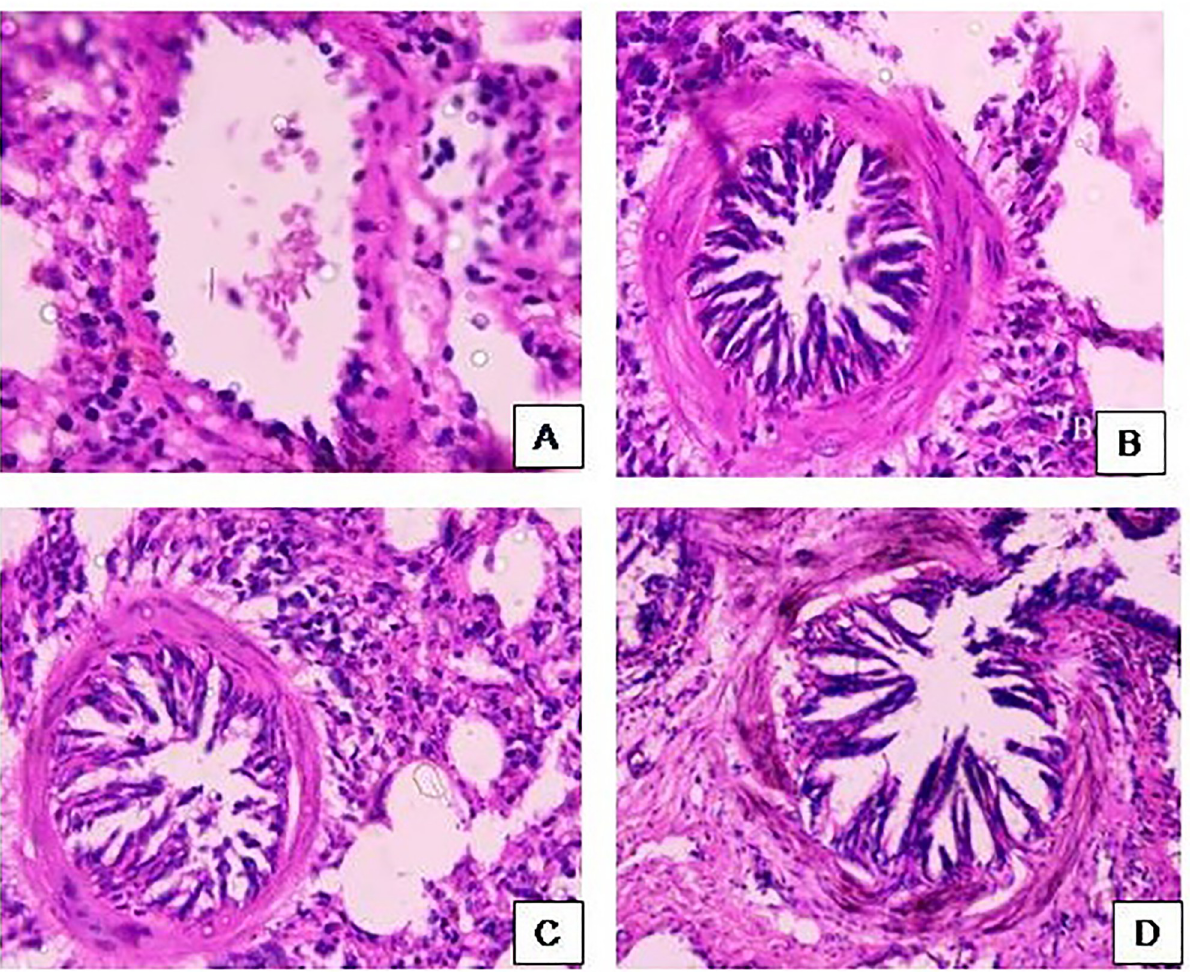
Fig 8. Histopathological images of lung of (A) na ï ve control, (B) OVA sensitized control, (C) orally treated, and (D) nasally treated animals.